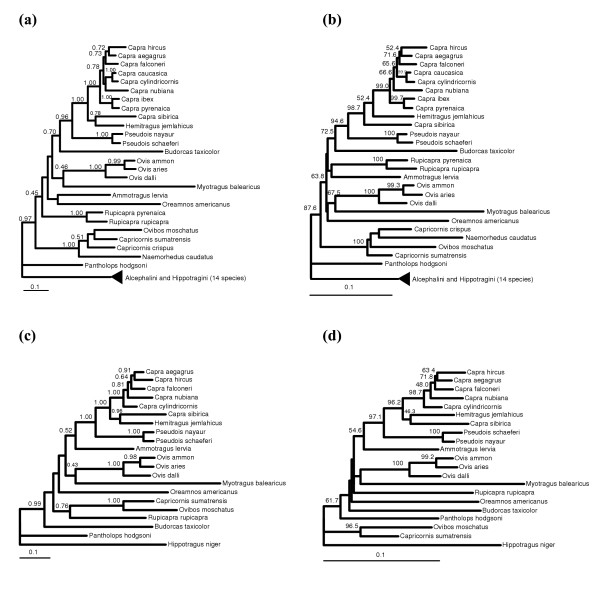
Bayesian tree (a) and maximum-likelihood tree (b) of the entire cytochrome b of all Caprinae species in databases. Bayesian tree (c) and maximum-likelihood tree (d) of the concatenated cytochrome b plus a 12S fragment of all Caprinae species in databases with both sequences. Bootstrap per cent values higher than 40% (maximum-likelihood tree) and support values bigger than 0.4 (Bayesian tree) are depicted in the nodes. The scale bar represents 0.1 substitutions/site.